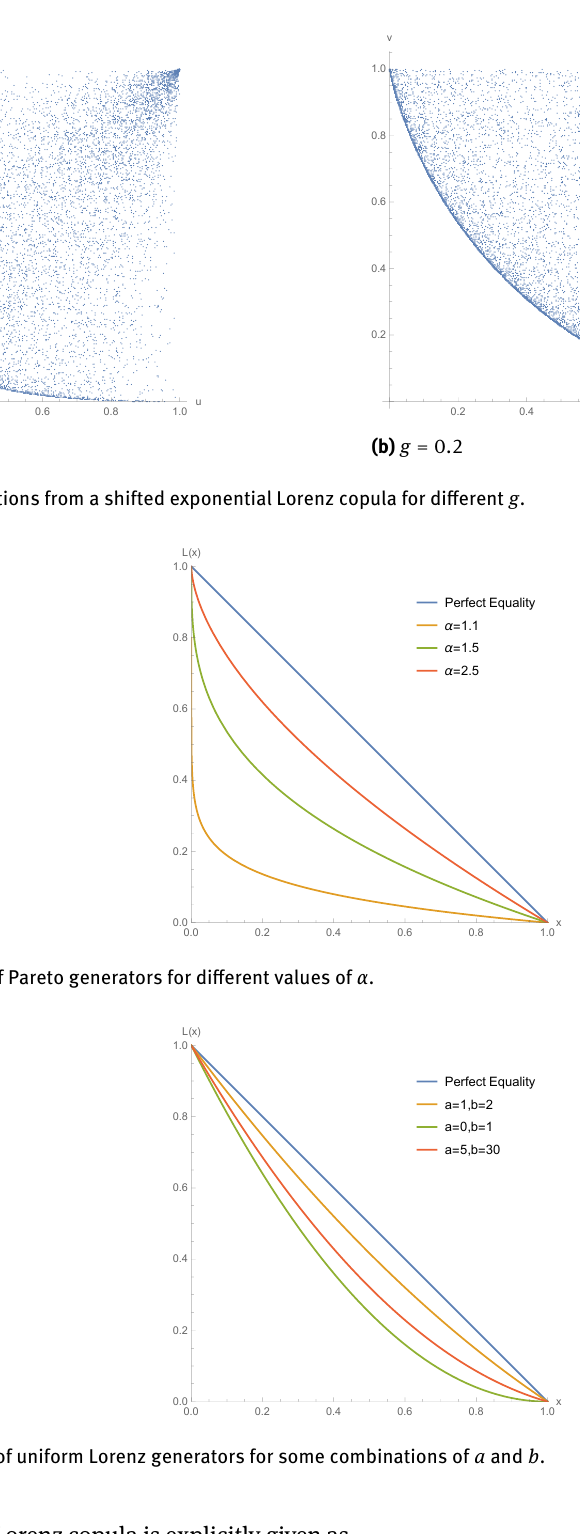
The uniform Lorenz copula is explicitly given